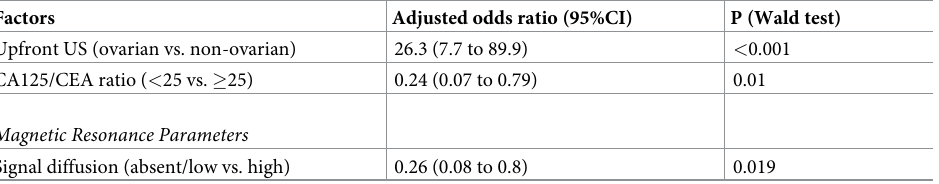
Signal diffusion (absent/low vs.